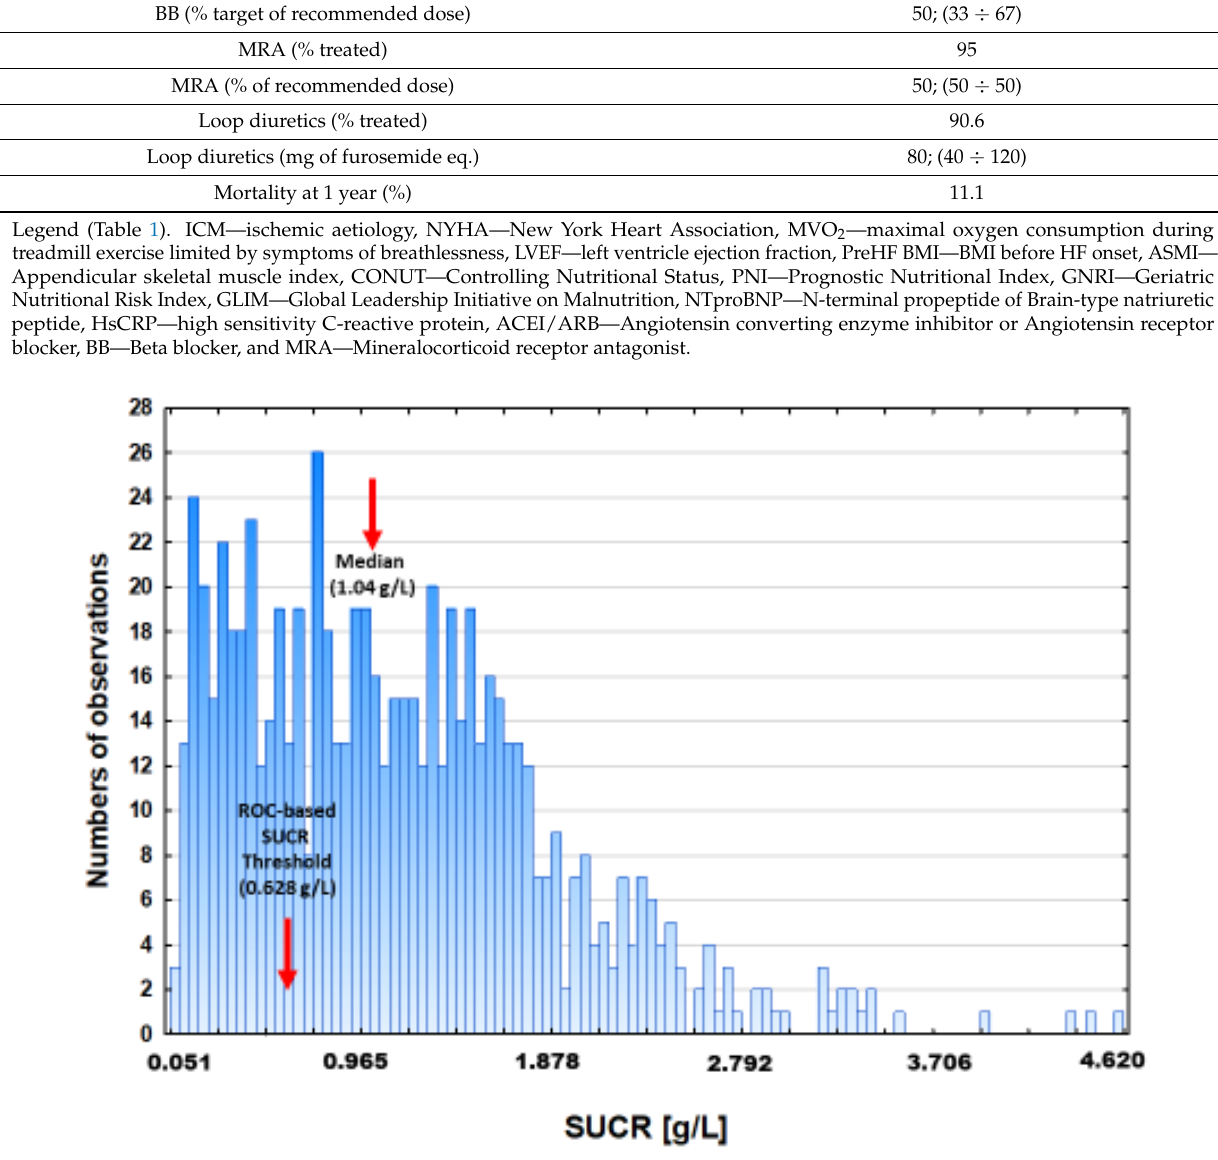
Figure 1. The distribution of SUCR in the study cohort and cut-off point identified by ROC analysis (N = 721). The study group was split according to SUCR cut-off value identified using ROC analysis of 1 year all-cause mortality data. During the follow-up, 80 (11.1%) patients died. The calculated area under receiver operating characteristics for SUCR was 0.580; (95%CI: 0.523 – 0.632), p = 0.006, and the optimal cut-off separating dead from alive was 0.628 g/L. The division of the study cohort according to this point produced a group of 221 (30.7%) patients falling below and 510 (69.3%) above the SUCR threshold (Table 2).